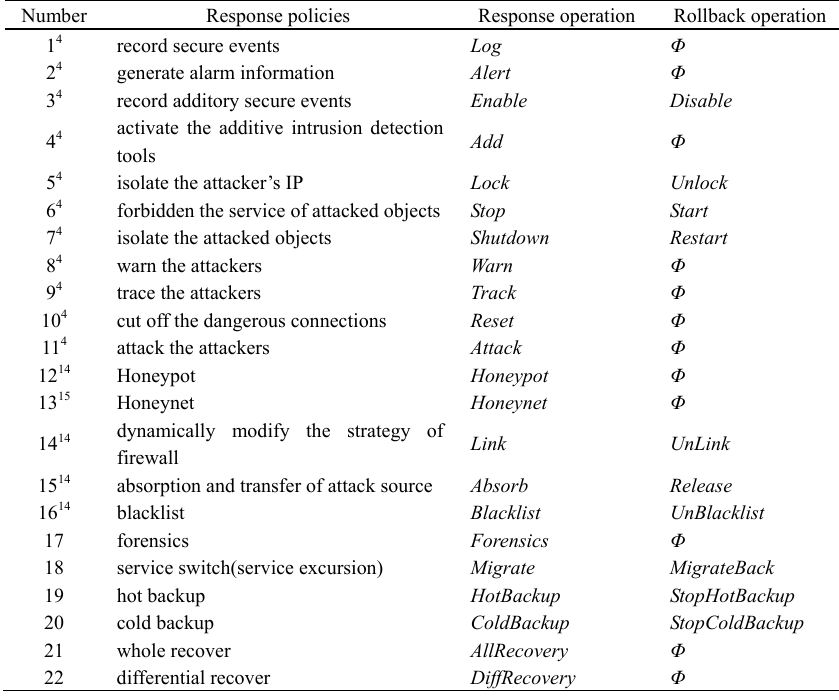
Table 1. The network-based intrusion response policies